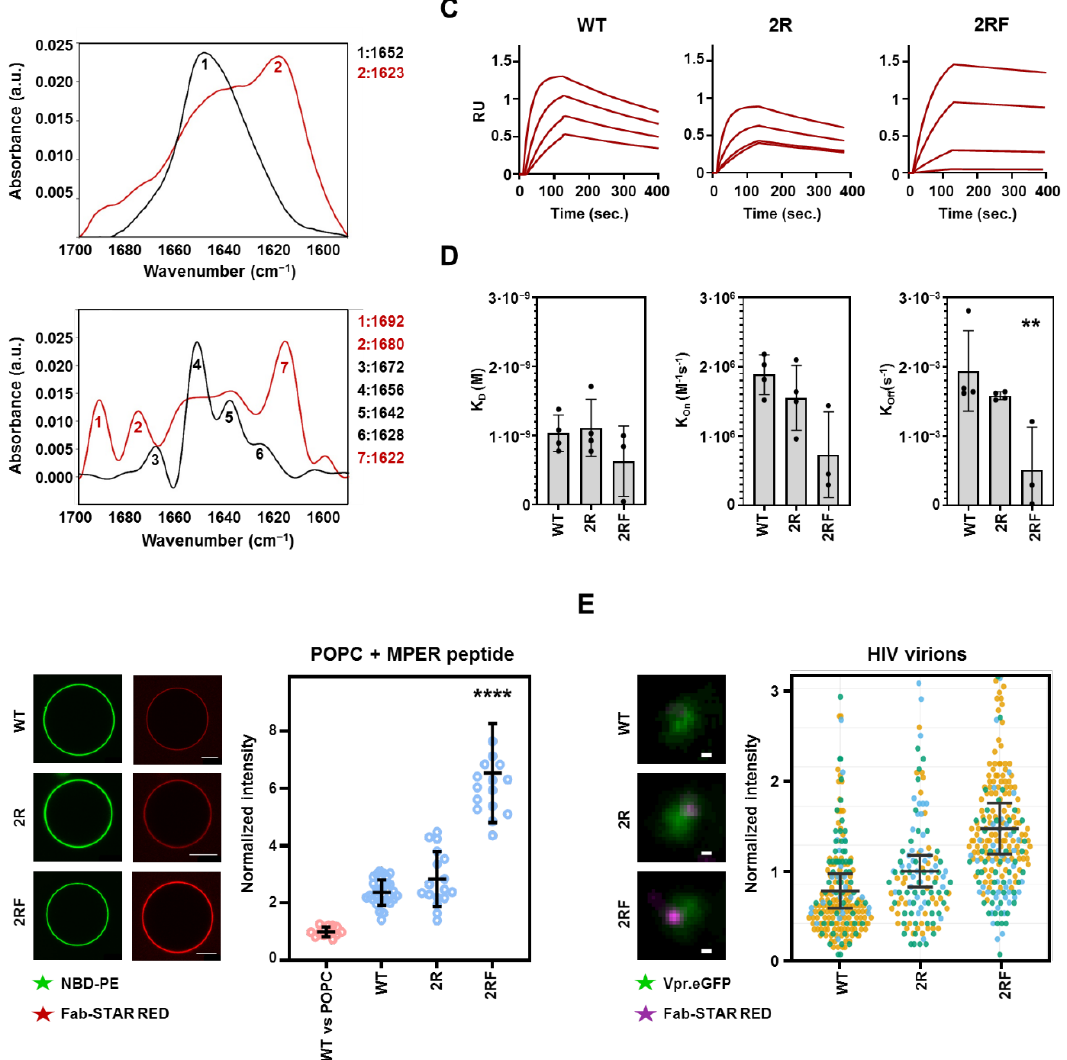
Figure 5. Binding comparison of MPER epitope reconstituted in lipid membranes . ( A ) Top: Infrared spectra of MPER-TMD 671 – 709 peptide in PBS (red) and reconstituted in POPC vesicles (black) in the amide I region. Bottom: after deconvolution the spectra display the different components of the absorption bands. Wavelengths corresponding to the main peaks (labeled 1 – 7) are displayed for clarity. ( B ) Representative (left) and quantitative (right) binding of 10E8 variants to POPC vesicles containing reconstituted MPER-TMD 671 – 709 helices (number of vesicles n ≥ 17). The 10E8-WT binding to vesicles without peptides was added for reference (red dots). Scale bars, 5 μm. **** indicate sig- nificance compared to 10E8-WT Fab ( p < 0.0001) by Kruskal – Wallis test. ( C , D ) Sensograms ( C ) and kinetic parameters ( D ) of 10E8 Fab variants binding to supported lipid bilayers that contained re- constituted MPER-TMD peptides obtained by surface plasmon resonance (SPR). ** indicates signif- icance compared to 10E8-WT Fab ( p < 0.01) by one-way ANOVA. ( E ) Left, STED super-resolution images of STAR RED-labelled Fabs (magenta) bound to native Env in individual virions labelled with Vpr.mCherry (green). Scale bars, 100 nm. Right, quantification of the Fab signal from individ- ual HIV-1 virions from STED super-resolution images. Measured photon counts were normalized to the median signal of the 10E8-WT Fab. Each dot represents the signal from an individual virion (n WT = 233, n 2R = 156, n 2RF = 278) and colors represent each of three independent experiments per- formed. Finally, we compared the binding affinity of the different 10E8 Fabs to native Env in intact virions using super-resolution stimulated emission depletion (STED) microscopy (Figure 5E) [5]. In this technique, the number of photons measured is directly proportional